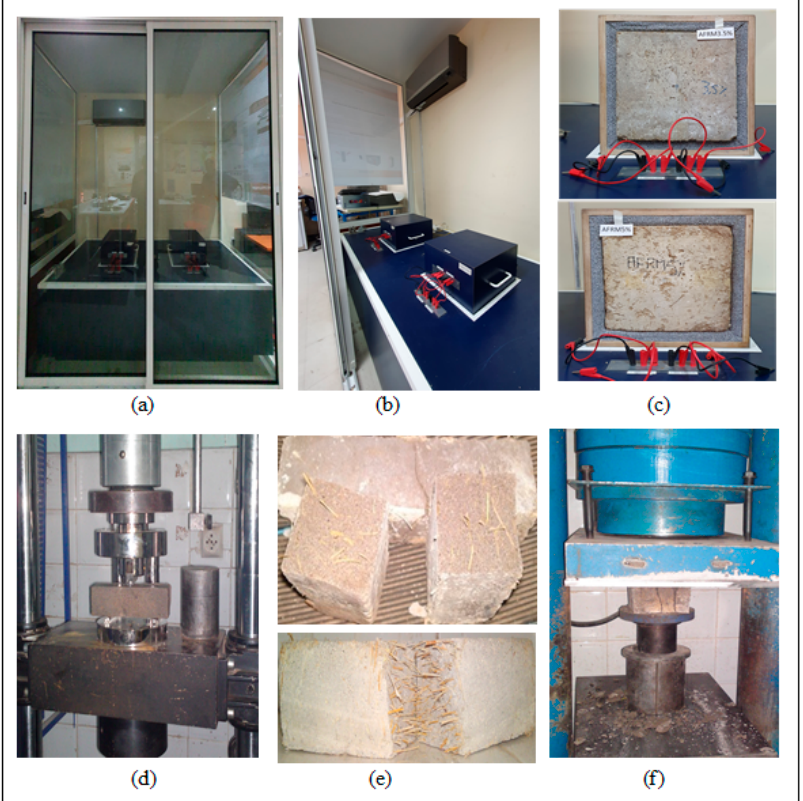
Figure 4. Devices used for thermo-mechanical tests: ( a ) air conditioned chamber, ( b ) two boxes method, ( c ) boxes of measured thermal conductivity and diffusivity, ( d ) flexural test, ( e ) two half prisms obtained from flexural test and ( f ) compressive test.